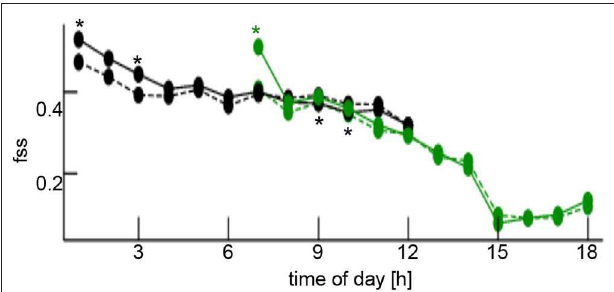
FIGURE 15 | Fraction skill scores (FSS) of precipitation rate forecasts against radar-derived precipitation in winter period 2016 as a function of time of day. The plot shows forecasts of experiments NO-SEVIRI (dashed) and SEVIRI-NEW (solid) for lead times from 1 to 12 h, colors encode initial time 00 h (black) and 06 h (green). FSS for initial times 12 and 18 h are not statistically different between NO-SEVIRI and SEVIRI-NEW. The stars denote statistically significant different scores between experiments (significance level is α = 0.10). Bootstrap method identical to the method applied in Figure 11 . The precipitation threshold is 1.0 mm and scale diameter is chosen to 11 grid